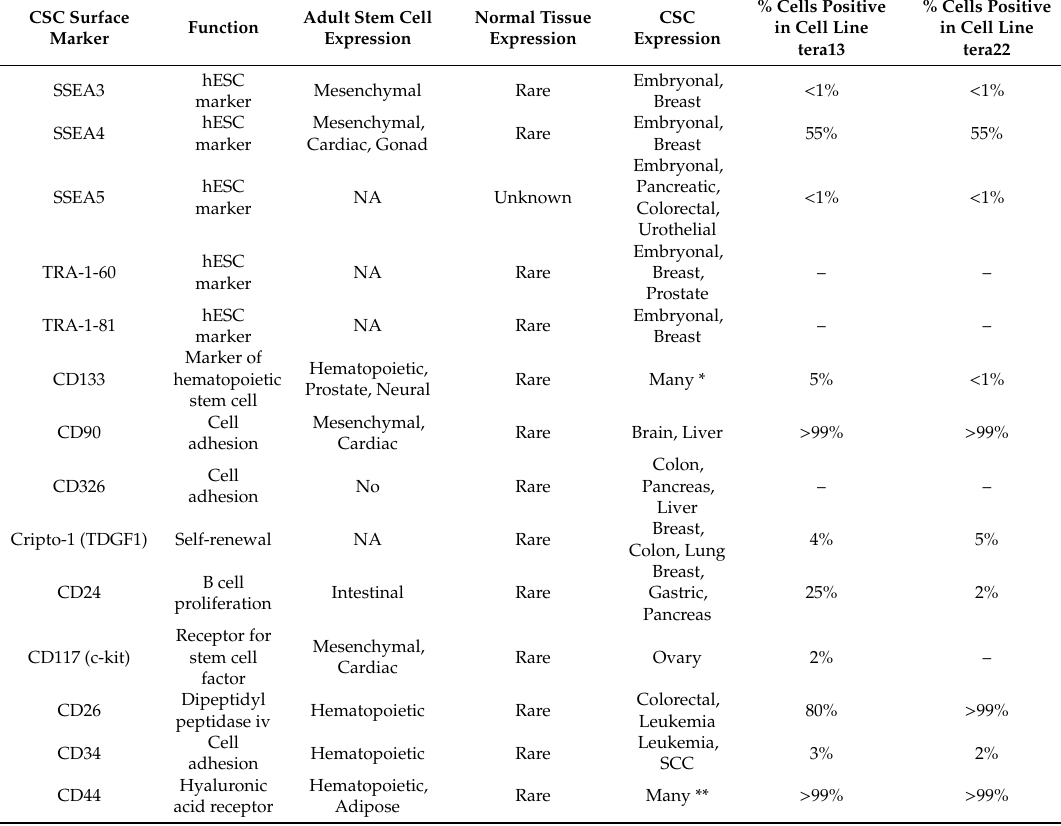
Table 3. Tera13 and Tera22 expressed cell surface markers by flow cytometry, suggesting their stem-like and multipotent